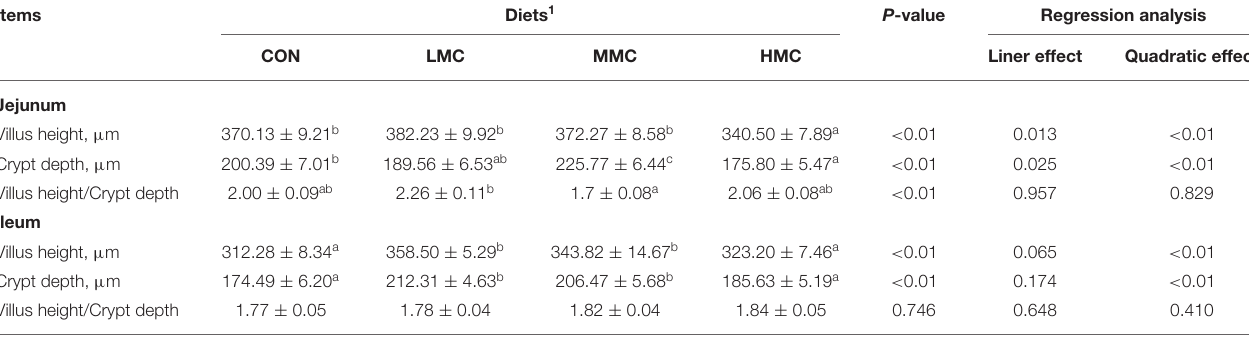
TABLE 6 | Effects of dietary Moutan cortex radicis on the morphology of the jejunum and ileum of growing pigs. Items Diets 1 P -value Regression